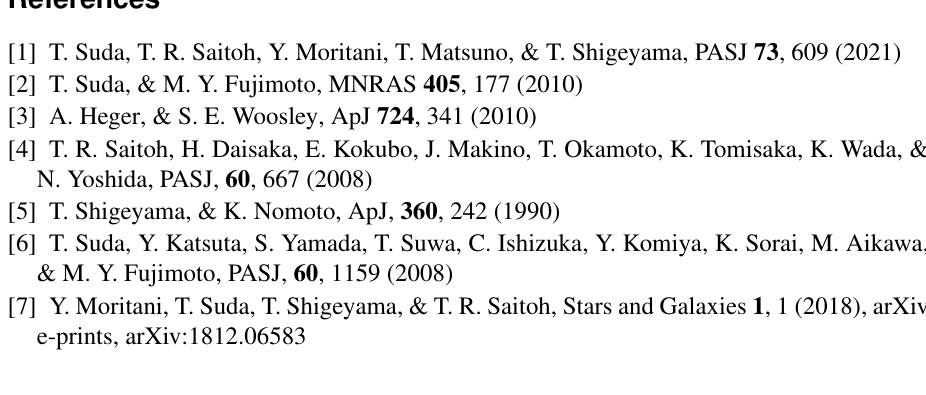
Figure 3. Determination of binary parameters for HD 93521. The derived parameters are given in the bottom left corner. The inner and outer conjuction, together with periastron are shown by the vertical